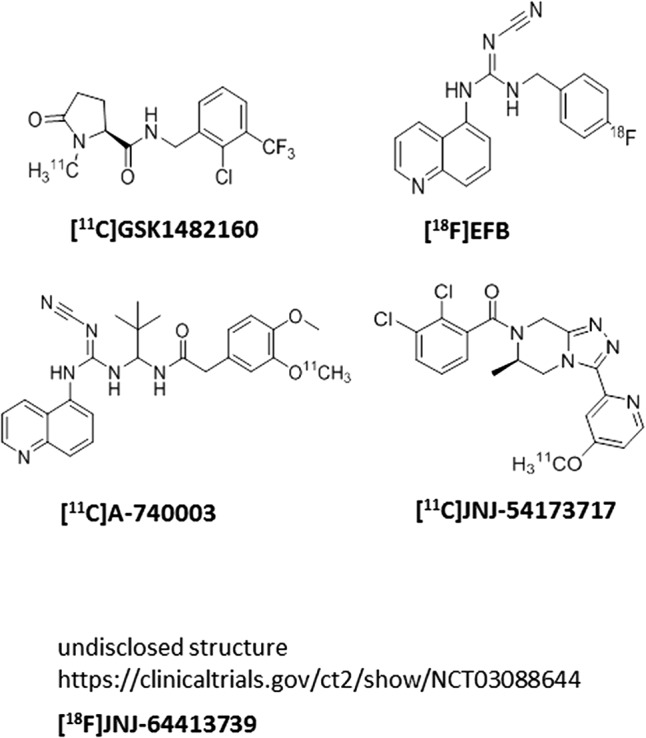
P2X7 PET ligands.